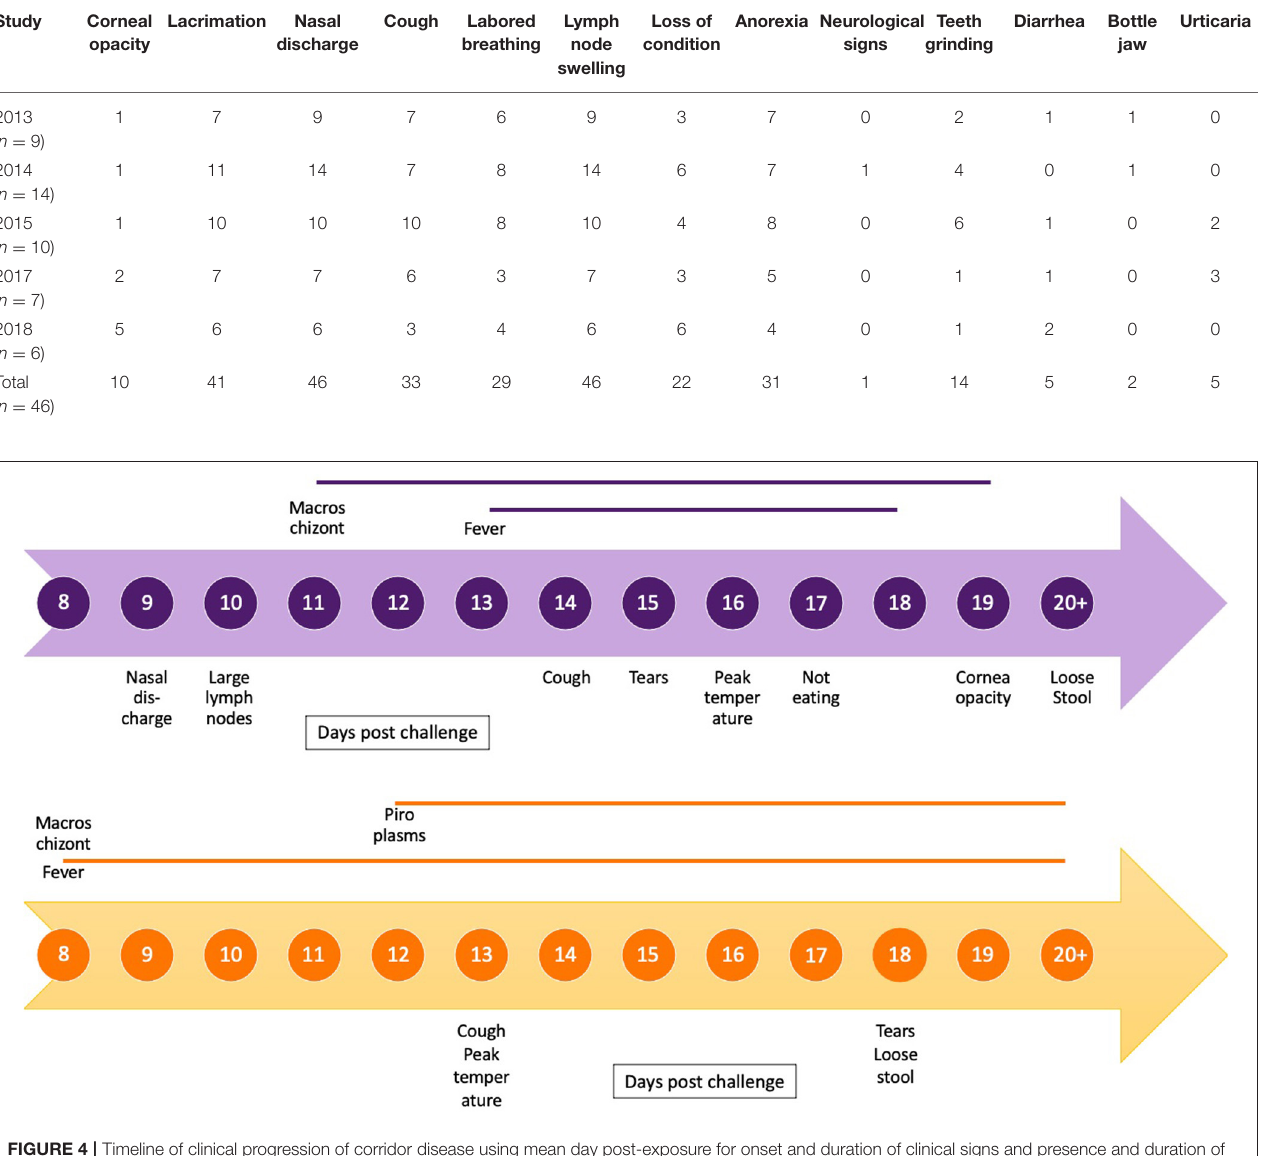
animals had pulmonary edema ( n = 27), and many animals had foam within the airways ( n = 25). The parotid and pre-scapular lymph nodes were enlarged in all animals, and the cut surfaces were edematous and/or hemorrhagic in most cases ( n =